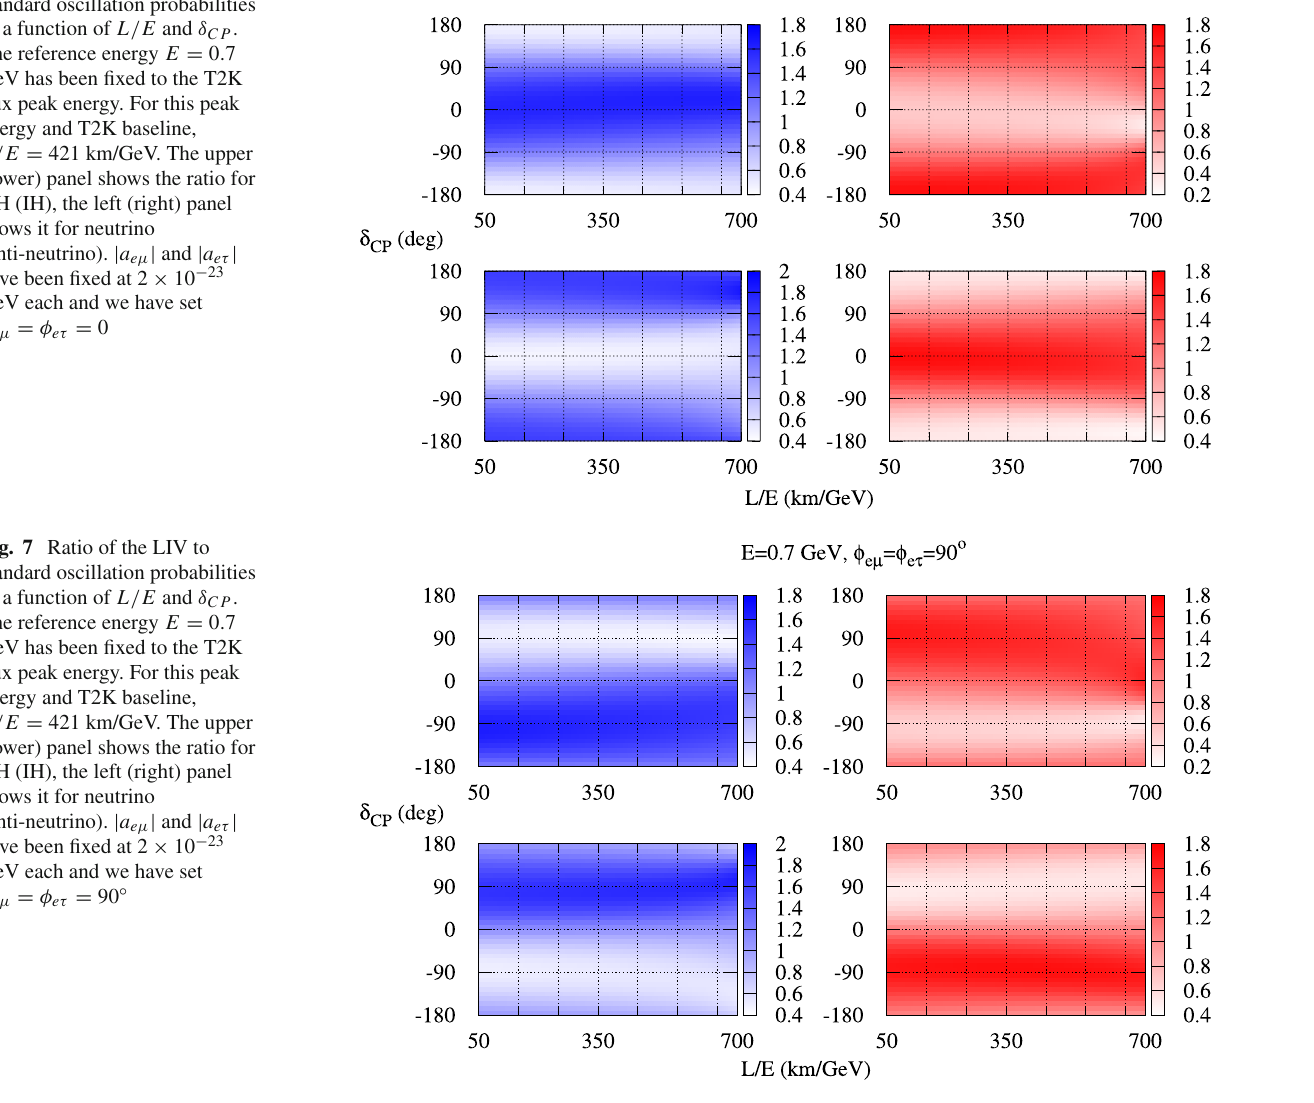
Fig. 6 Ratio of the LIV to standard oscillation probabilities as a function of L / E and δ CP .